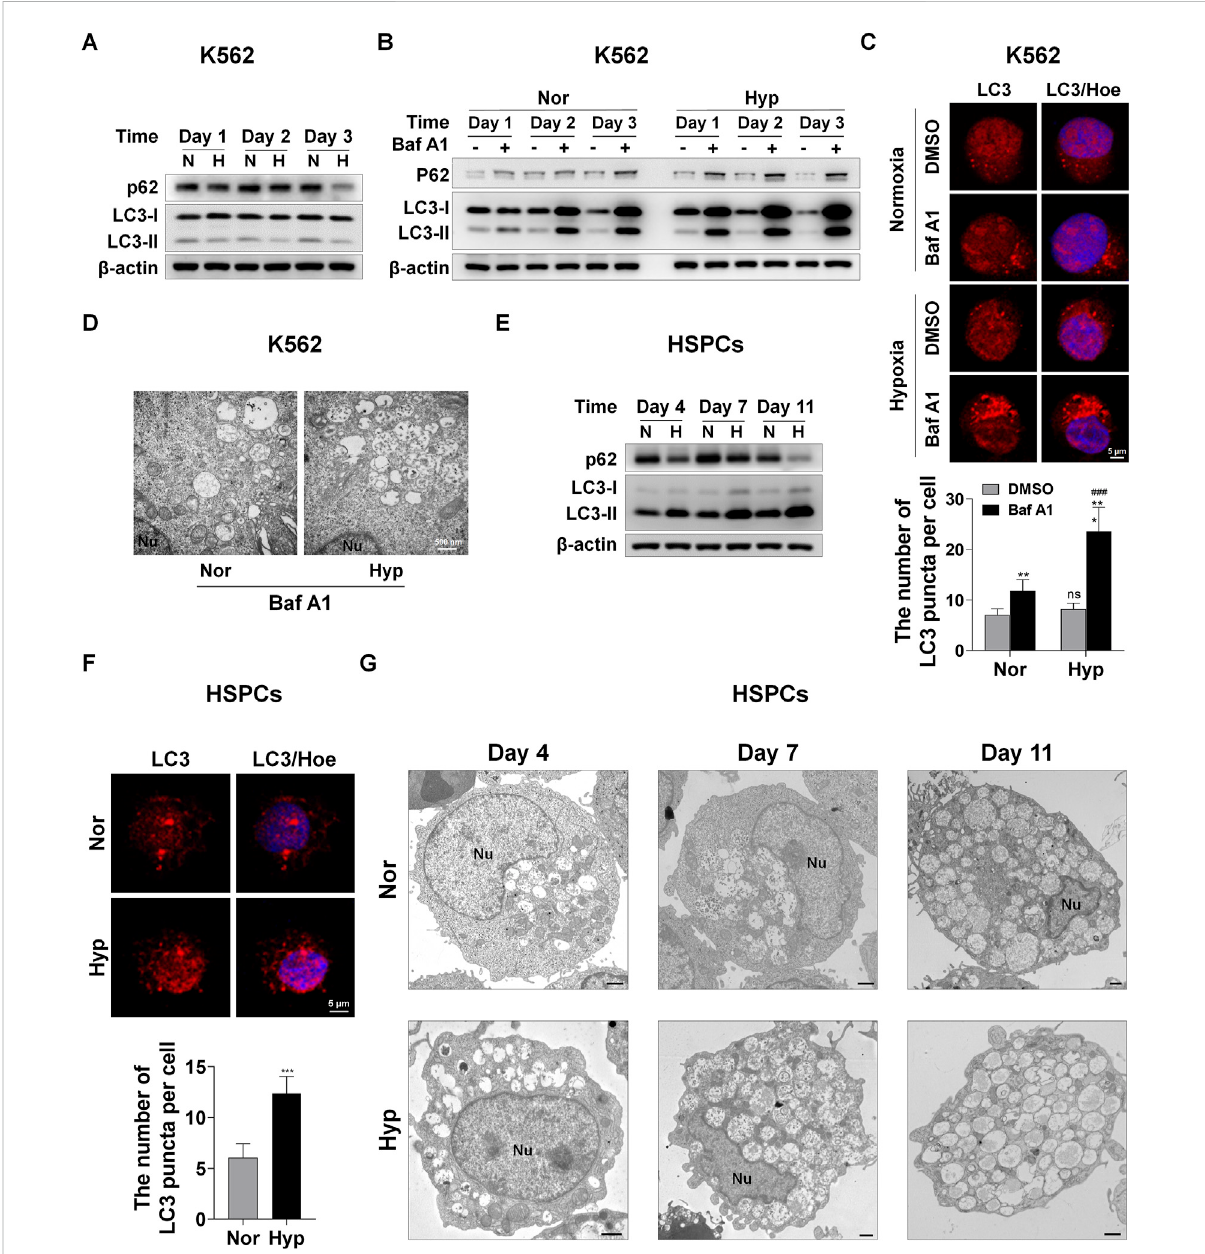
FIGURE 2 Hypoxia enhances autophagy during erythroid differentiation (A) Western blot analysis of p62 and LC3 protein expression at the indicated time points after K562 cells were exposed to normoxia or hypoxia during erythroid differentiation. N: normoxia; H: hypoxia (B) Western blot analysis of p62 and LC3 protein expression at the indicated time points after K562 cells treated with DMSO (-) as control or Baf A1 (+, 20 nM) were exposed to normoxia or hypoxia. Nor: normoxia; Hyp: hypoxia (C) Immuno fl uorescence analysis of LC3 puncta in K562 cells differentiated into erythrocytes. K562 cells were treated with DMSO or Baf A1 (20 nM) under normoxia or hypoxia for 48 h. Cell nucleus labeled with hoechst33342 (Hoe) is shown in blue, LC3 staining is shown in red and the merged images display their co-localization. Scale Bar = 5 μ m. The graph on the right shows the quanti fi cation of LC3 puncta per cell. ns, not signi fi cant., ### p < 0.001, versus the respective normoxia group. ** p < 0.01, *** p < 0.001, versus the corresponding DMSO group (D) TEM imaging of K562 cells treated with Baf A1 (20 nM) exposure to normoxia or hypoxia for 72 h. Representative imagesof autophagosomes are shown at 30000X. Nu: nucleus. Scale Bar = 500 nm (E) Westernblotanalysisof p62 and LC3 protein expression at the indicated time points after HSPCs differentiated into erythrocytes were exposed to normoxia or hypoxia. N: normoxia; H: hypoxia (F) Immuno fl uorescence analysis of LC3 puncta in HSPCs-derived erythrocytes. HSPCs were induced into erythrocytes under normoxia or hypoxia conditions for 7 days. Cell nucleus labeled with hoechst33342 (Hoe) is shown in blue, LC3 staining is shown in red and the merged images display theirco-localization.ScaleBar=5 μ m.Thegraphbelowshowsthequanti fi cationofLC3punctapercell.*** p < 0.001,versusthenormoxiagroup (G) TEM imaging of HSPCs-differentiated erythrocytes cultured under normoxia or hypoxia. Nu: nucleus. Scale Bar = 1 μ